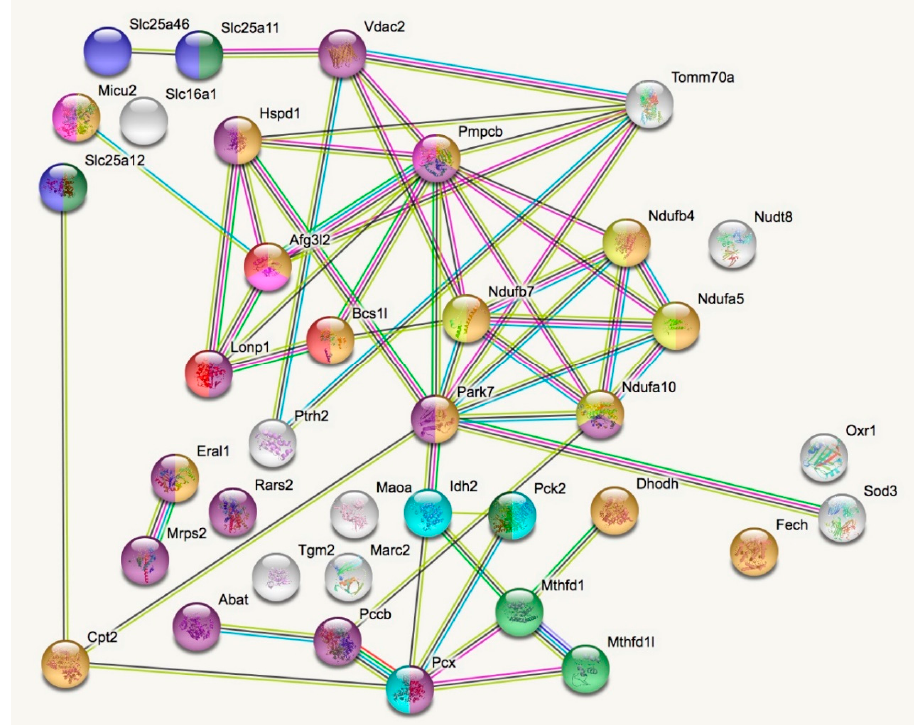
Figure 2. The STRING (Search tool for the retrieval of interacting genes) diagram of protein–protein interactions shows all significant dysregulations in mitochondria. In colors, it highlights mitochondrial matrix factors (violet), inner membrane proteins (orange), TCA cycle (Tricarboxylic acid cycle, Citric acid cycle, Krebs cycle) (light blue), gluconeogenesis (dark green), complex-I biogenesis (yellow), processing of Smdt1 (pink), formate-tetrahydrofolate ligase (light green), mitochondrial carrier domain superfamily (dark blue) and AAA+ ATPases (red). The membrane carriers and pore factors were manually placed in the left upper corner and upper margin, while the respiratory complex components were positioned in the right upper corner. LonP1 and its interaction with other disaggregases, proteases, and chaperones were located in the middle from left to center. The Eral1 mitoribosome chaperone and other translation components are shown towards the lower left corner, the breakdown of fatty acids/amino acids/one-carbon flux towards the lower center, and oxidative stress response in the lower right corner.